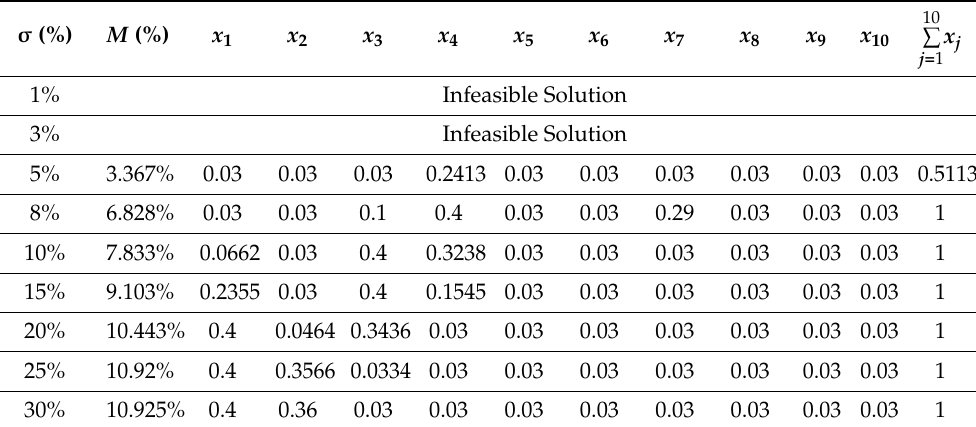
Table 7. The possibilistic efficient portfolios with recession stage by Chen and Tsaur’ model.